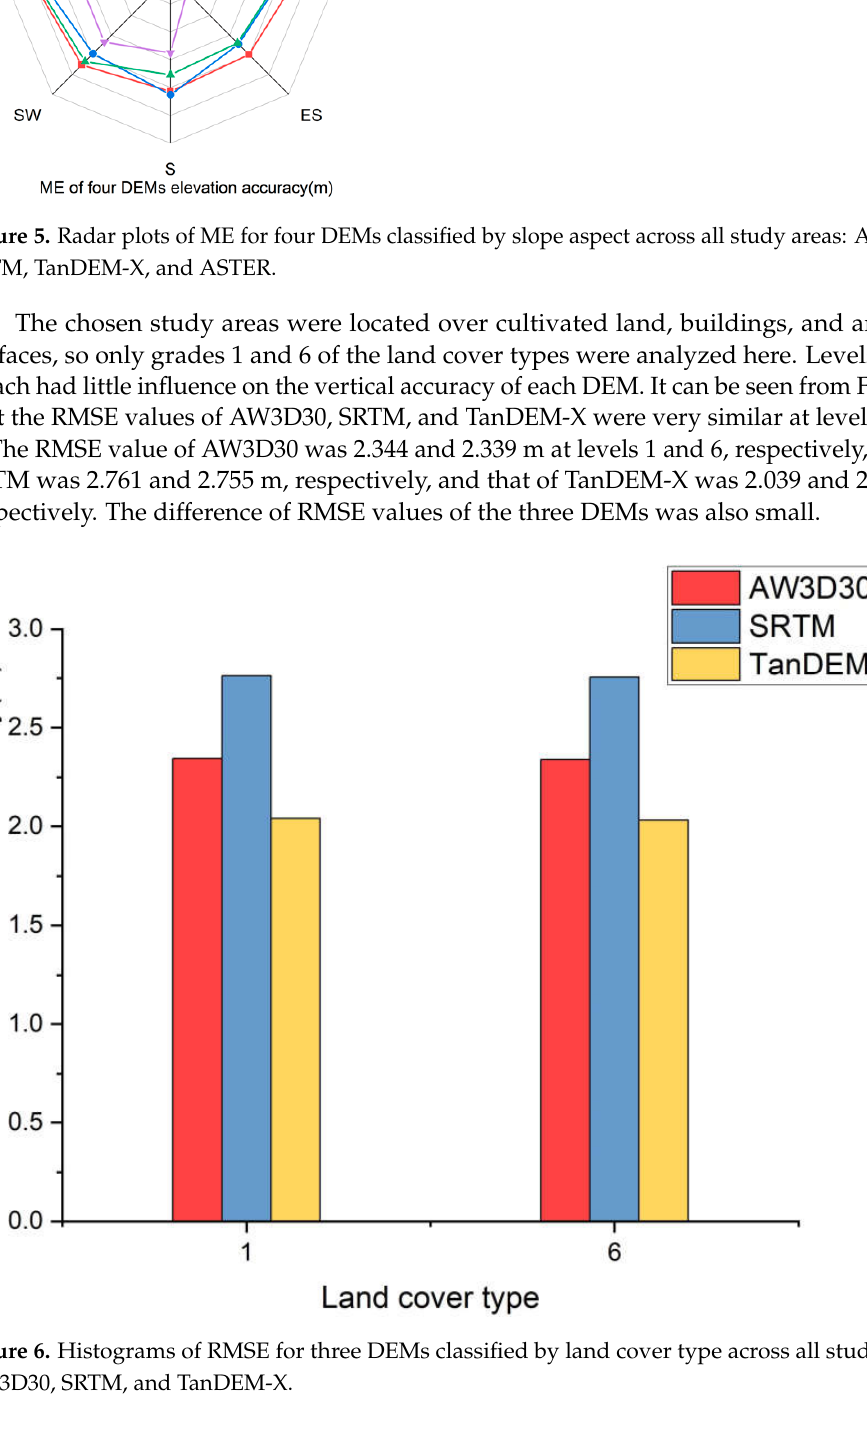
Figure 6. Histograms of RMSE for three DEMs classified by land cover type across all study areas: AW3D30, SRTM, and